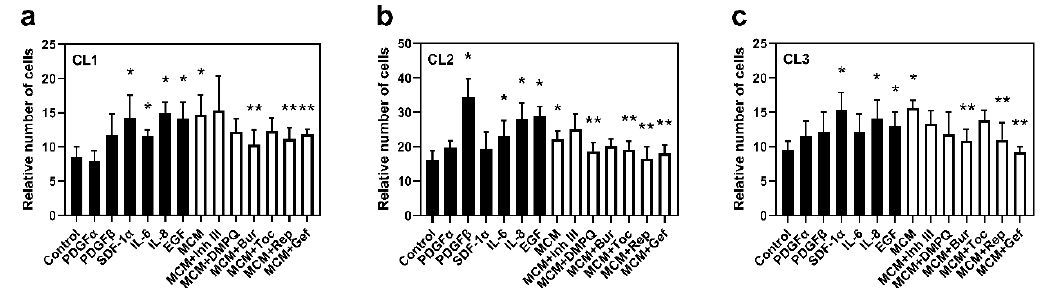
Figure 5. Cytokines released by microglia stimulate glioma cell viability. A trypan blue exclusion test was performed to evaluate glioma cell viability. The number of viable cells was calculated after treatments with cytokines and microglia- condition medium (MCM), with or without the corresponding cytokine inhibitors, in the cell lines ( a ) CL1, ( b ) CL2, and ( c ) CL3. The values are shown as means ± SD of 3–6 experiments per group. * p < 0.05 vs. control, ** p < 0.05 vs. MCM. Inh III, inhibitor III; Bur, burixafor; Toc, tocilizumab; Rep, reparixin; and Gef, gefitinib. SDF1 α increased viability in CL1 and CL3 (by 68 and 62%, respectively, p < 0.05; Fig- ure 5a,c), while burixafor reduced the stimulatory effect of MCM in all investigated cell